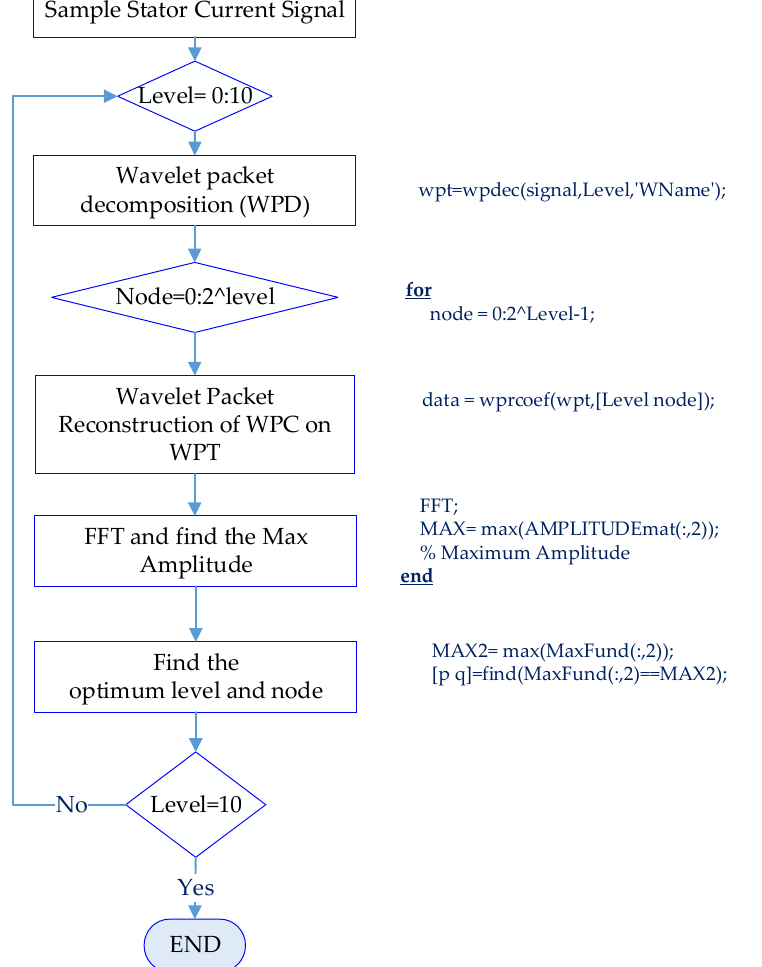
Figure 5. Wavelet packet signature analysis (WPSA) ‐ based algorithm.